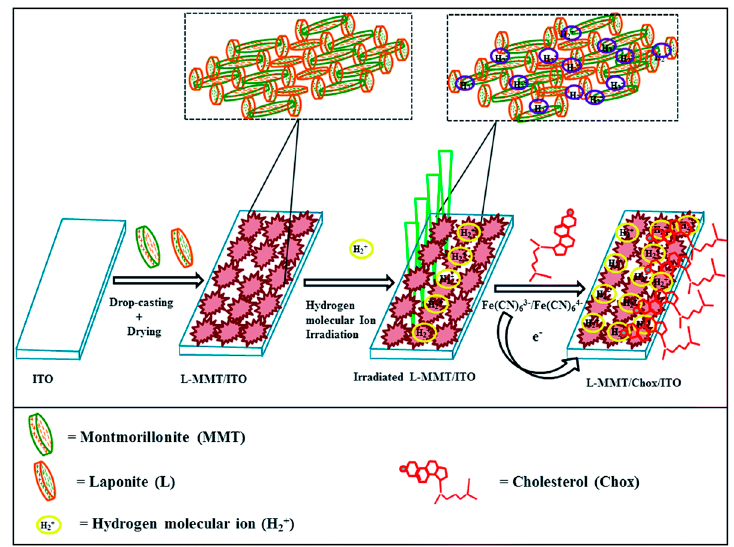
Figure 5. Schematic fabrication and irradiation of L-MMT/ITO film with H 2+ ion beam for sensing cholesterol. Reprinted with permission from Ref. [48].